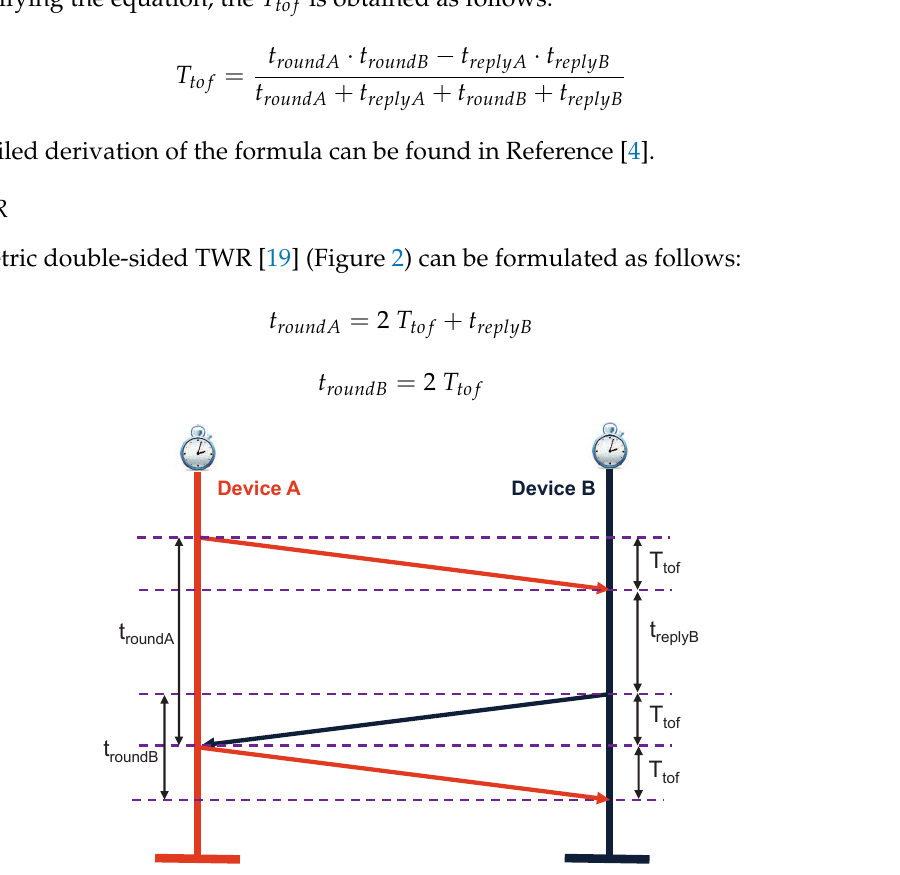
Figure 2. Illustration of the asymmetric double-sided TWR method ( c (cid:13) 2018 IEEE. Reprinted with